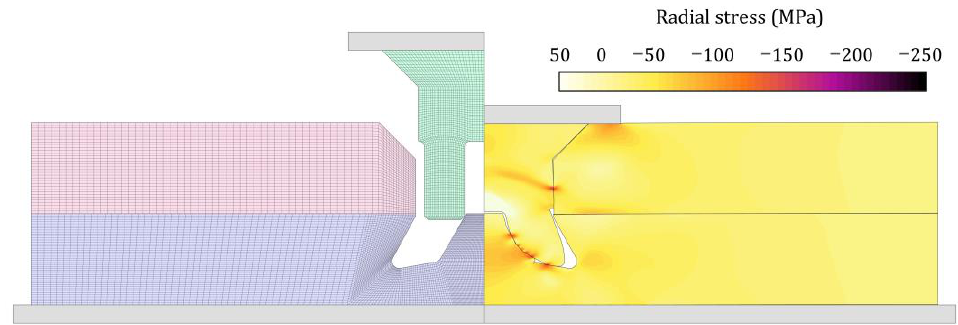
Figure 7. Finite element simulation of injection lap riveting countersunk head rivets, showing the mesh at the beginning ( left ) and the distribution of radial contact pressure (MPa) at the end of the stroke ( right ) for unit cells with 𝛼 = 30°,𝑑 𝑝 = 3 mm